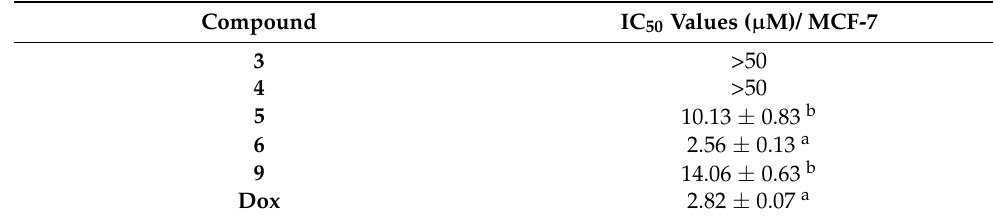
Table 1. In vitro anti-cancer activity of quinolinone derivatives 3–6 and